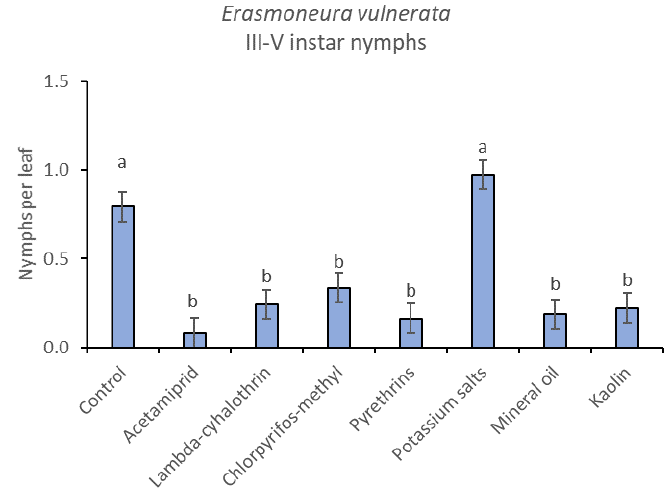
Figure 11. Least-square means ( ± std. err.) of Erasmoneura vulnerata older (III-V instar) nymphs observed on different treatments in the 2018 trial. Different letters indicate significant differences at t -test ( α = 0.05).